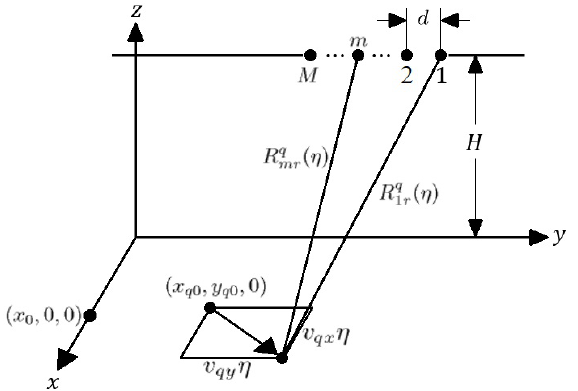
Figure 2. Schematic of airborne multi-channel SAR imaging on a moving point